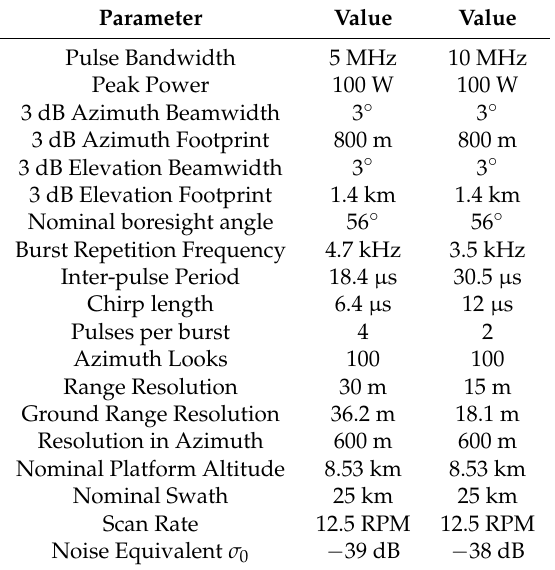
Figure 5. DopplerScatt pulse configuration and usage example. Phase differences are taken between subsequent bursts and are used to compute radial surface currents. Backscatter measurements are made using the average return power of pulses within each burst and are used to compute winds. Table 2. DopplerScatt Instrument Configuration for 5 and 10 MHz